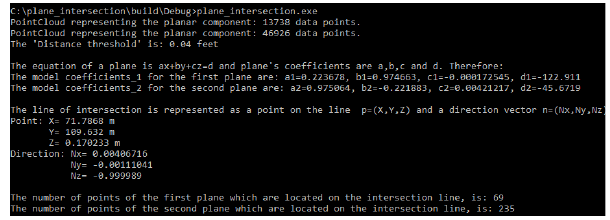
Figure 6. Imaging Edge Detection Results on 2 planes The results are visualized in figure 7.